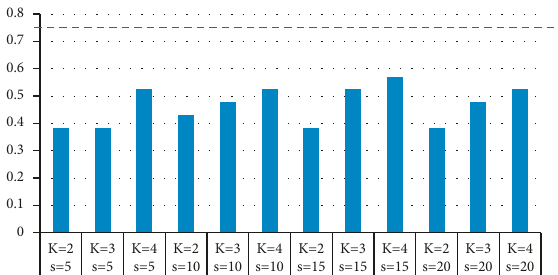
Figure 2: Sensitivity of CBCD on GS with a threshold